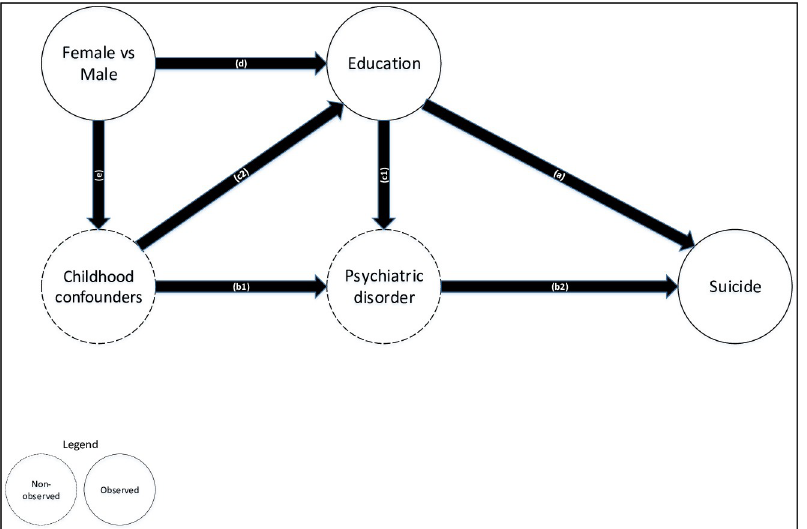
Fig 1. Theoretical model of educational disparities in suicide, with unobserved and observed variables in the DEMETRIQ